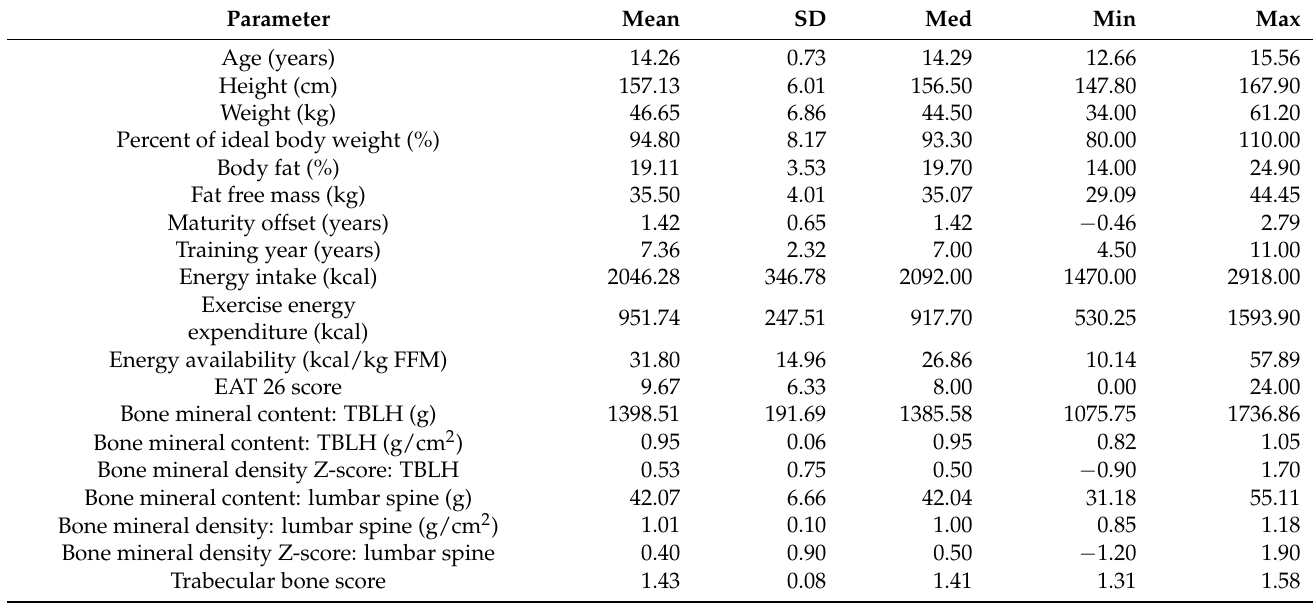
Table 1. Characteristics of participants ( n = 21).